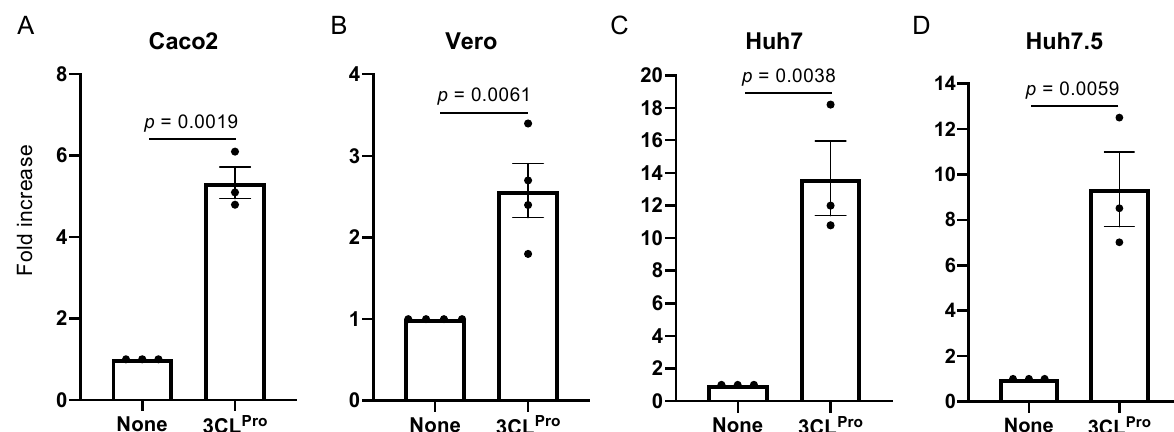
Figure 2. Activation of the luminescent biosensor by SARS-CoV-2 3CL Pro expression in different cell lines. ( A – D ) Caco-2, E6 Vero, Huh7 and Huh7.5 cells were stably transfected with a lentiviral vector to constitutively express the 3CL Pro luminescent biosensor. Stable cell lines were transfected with an expression plasmid that was either empty (None) or encoding SARS- CoV-2 3CL Pro . After 24 h of culture, luciferase activity in culture wells was determined. Data correspond to means ± SEM from 3 independent experiments in triplicate and p values were determined by Student’s t